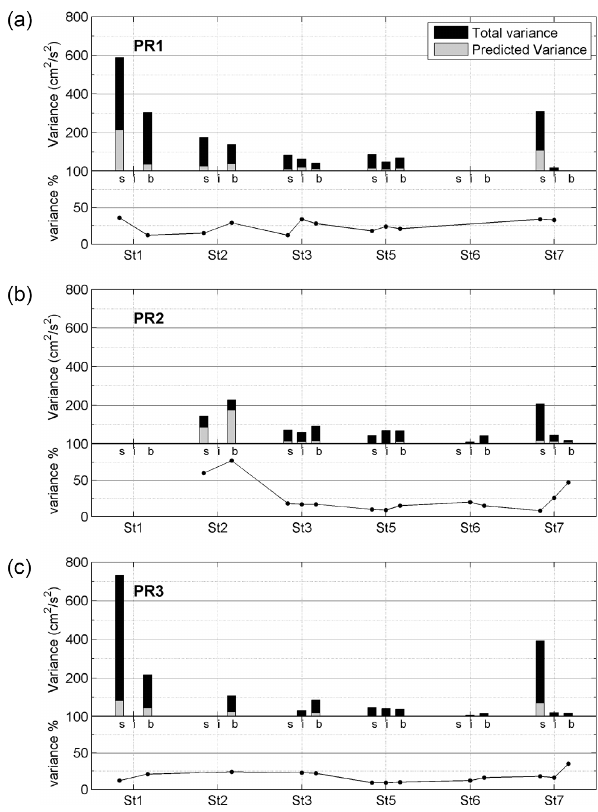
Fig. 3. Total variance (black bars), predicted variance (grey bars), and the contribution of predicted to total (%; continuous line) due to all resolved tidal constituents along the Otranto section, from OTRANTO/OGEX data for the three time intervals PR1 (a) , PR2 (b) and PR3 (c) . Symbols s, i, and b stand for surface, intermediate and bottom layers, respectively.